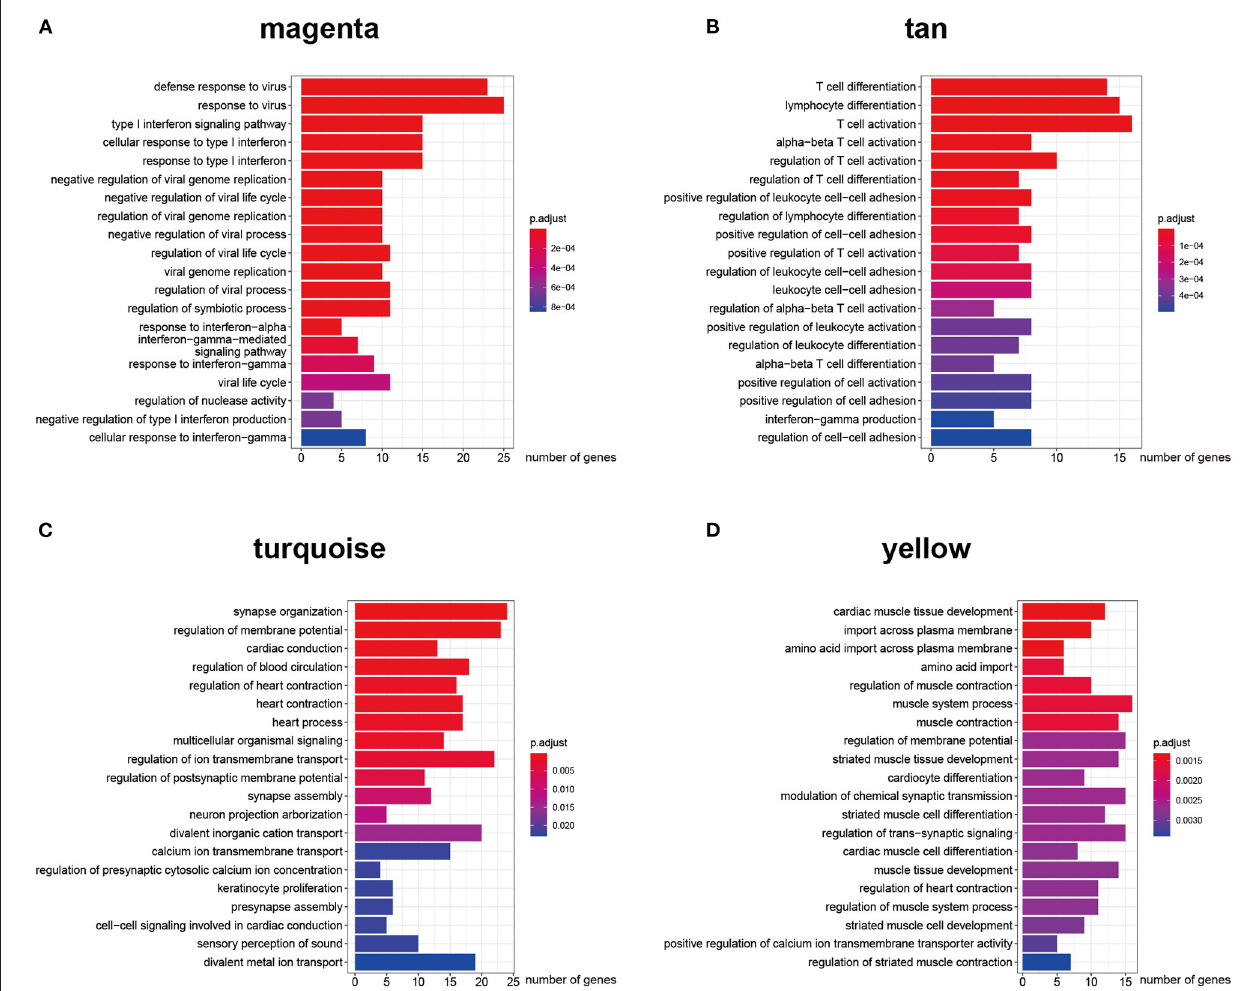
FIGURE 4 | Gene ontology biological process enrichment analysis for each ceRNA network. (A–D) Top 20 enriched gene ontology biological process terms of protein-coding genes in AF susceptibility-associated magenta (A) and tan (B) ceRNA networks, and AF persistence-associated turquoise (C) and yellow (D) ceRNA